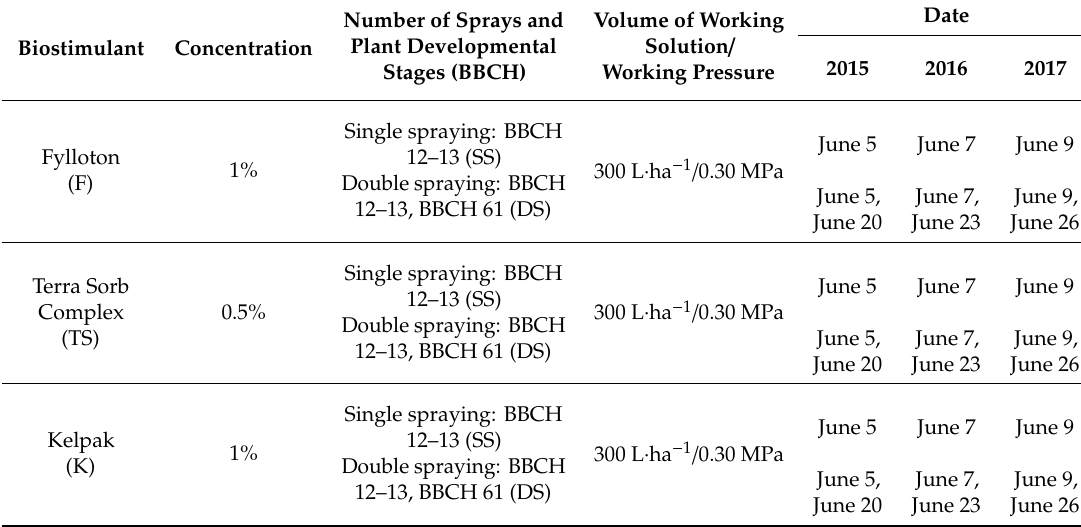
Table 1. Overview of biostimulant application in bean variety Oczko